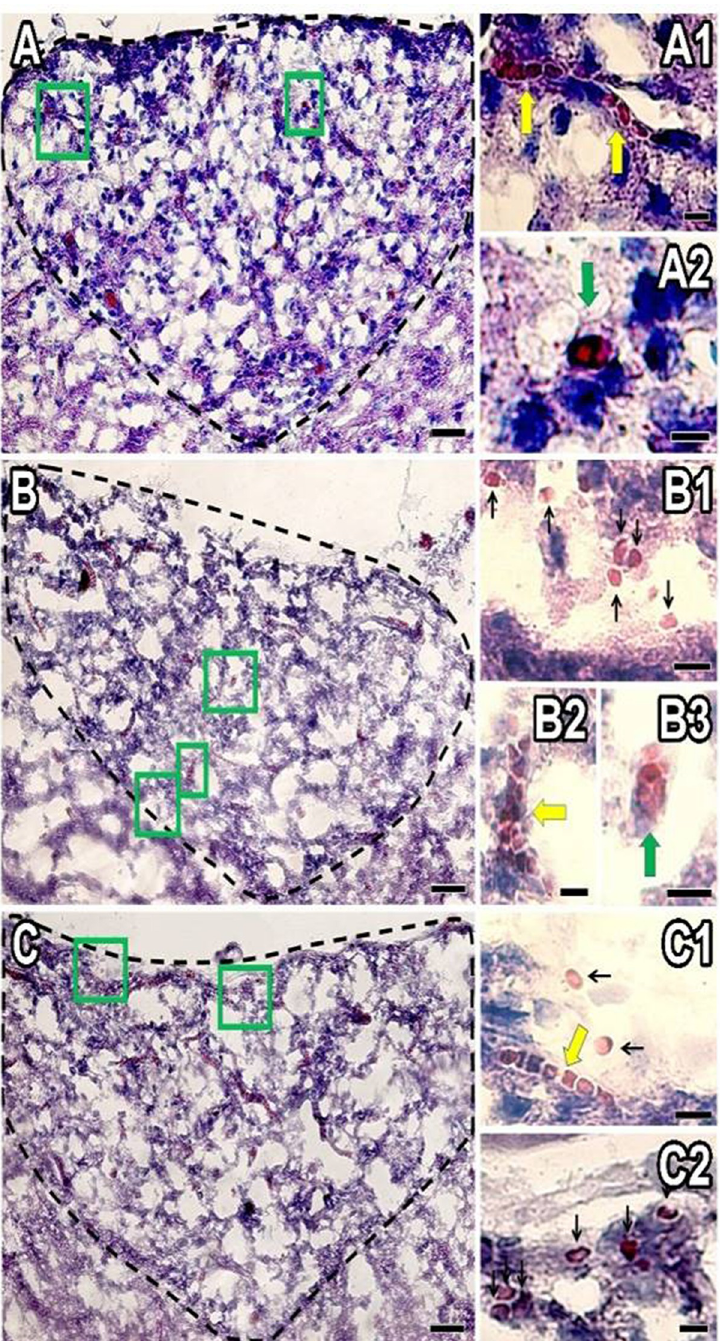
Fig 3. Effect of LAv on AP. (A) Control treatment AP section; (A1) magnification of Fig 3A, longitudinal view of a healthy capillary; (A2) magnification of Fig 3A, transversal view of a healthy capillary; (B) 0.178 μ g/g LAv treatment AP section; (B1) magnification of Fig 3B, showing abnormal extravasated erythrocytes; (B2) magnification of Fig 3B, longitudinal view of a capillary damaged by LAv; (B3) magnification of Fig 3B, transversal view of a capillary damaged by LAv; (C) 0.89 μ g/g LAv treatment AP section; (C1) magnification of Fig 3C, transversal view of a capillary damaged by LAv and extravasated erythrocytes; (C2) magnification of Fig 3C, showing abnormal extravasated erythrocytes. Black arrows indicate extravasated erythrocytes and red arrow heads indicate capillaries. Scale bars: A, B and C = 50 μ m; A1, A2, C1 and C2 = 10 μ m; B1-B3 = 20 μ m.